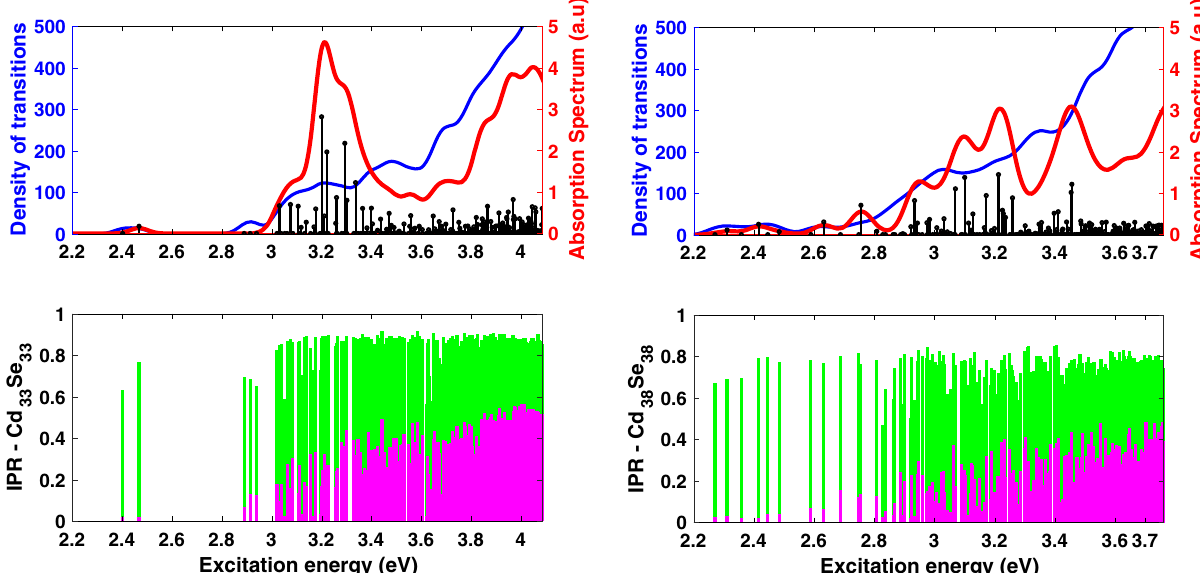
Fig. 3 Effect of dot size on the spectrum and IPR. Top: Absorption spectrum in arbitrary units (red), density of transitions (blue), and individual excitations (black sticks) for Cd 33 Se 33 (left) and Cd 38 Se 38 (right) with methylamine ligands. Bottom: Inverse participation ratio (IPR) for Cd 33 Se 33 (left) and Cd 38 Se 38 (right) with methylamine ligands. In each case, the number of excited states is chosen to be equal to that of the 2 nm NC in Fig. 2. The number of low energy, surface-associated transitions clearly increases with NC